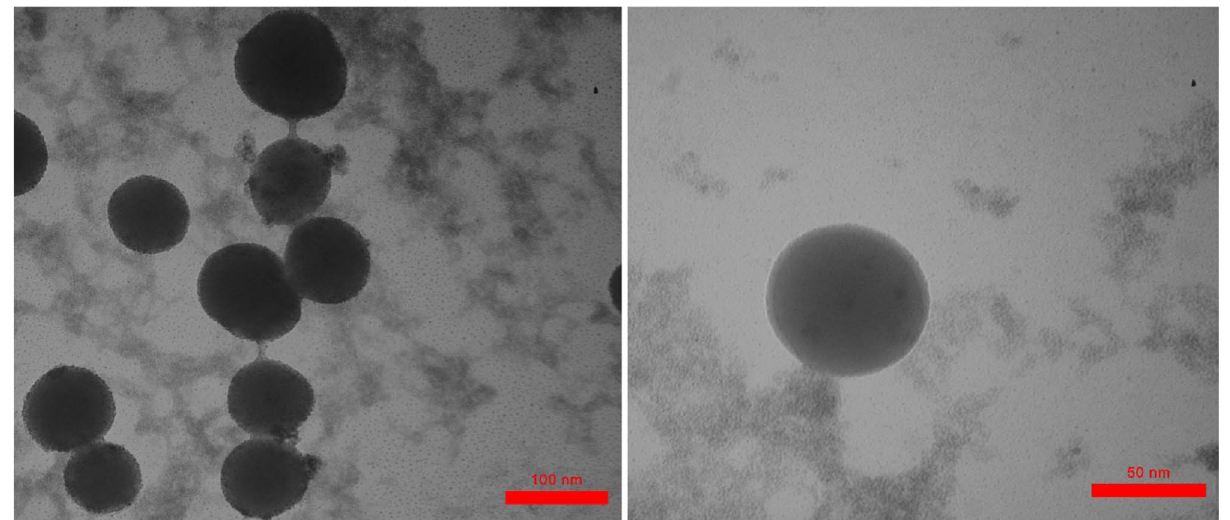
Figure 5. Transmission electron microscopy (TEM) images of Fe 3 O 4 @Co(BDC)-NH 2 .